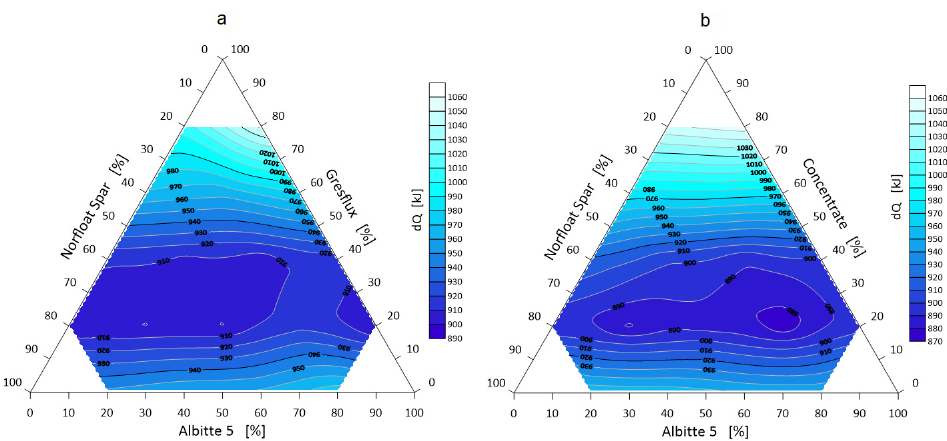
Figure 11. Transformation energy ∆ Q of the three-component system, Greslux ( a )/Concentrate ( b ) – Albitte 5–Norfloat Spar .